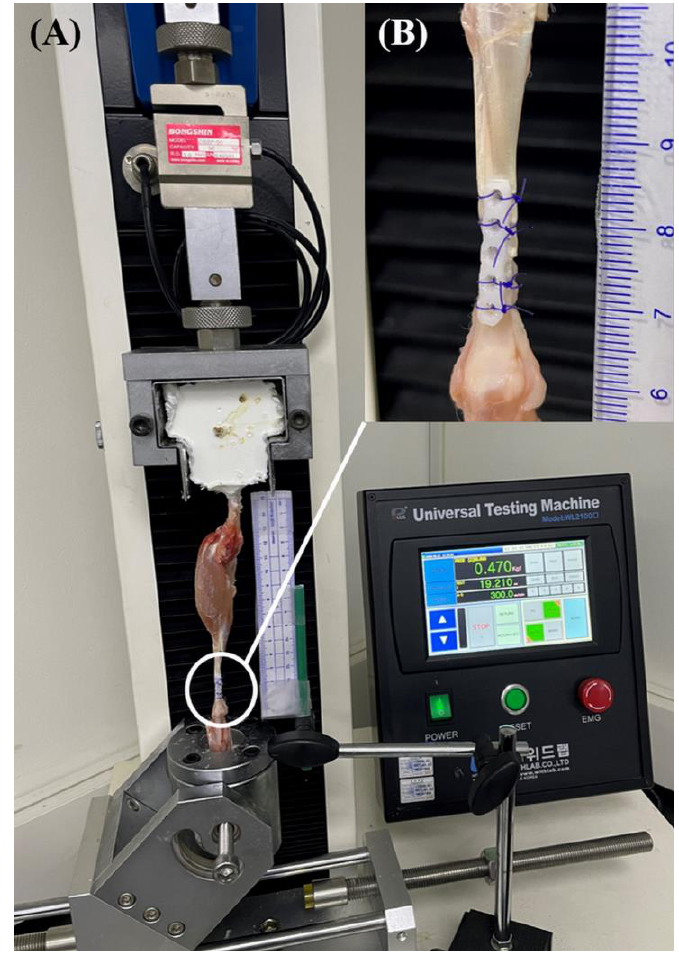
Figure 3. ( A ) Mechanical testing apparatus with a repaired superficial digital flexor tendon specimen within the custom testing jig attached to the material testing machine. ( B ) Magnified photographic image of a transected tendon repaired with a three-loop pulley pattern in conjunction with a five-hole 2-mm PCL plate .